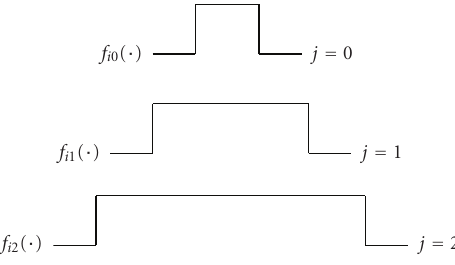
Figure 2: Dilation of basis functions at multiple